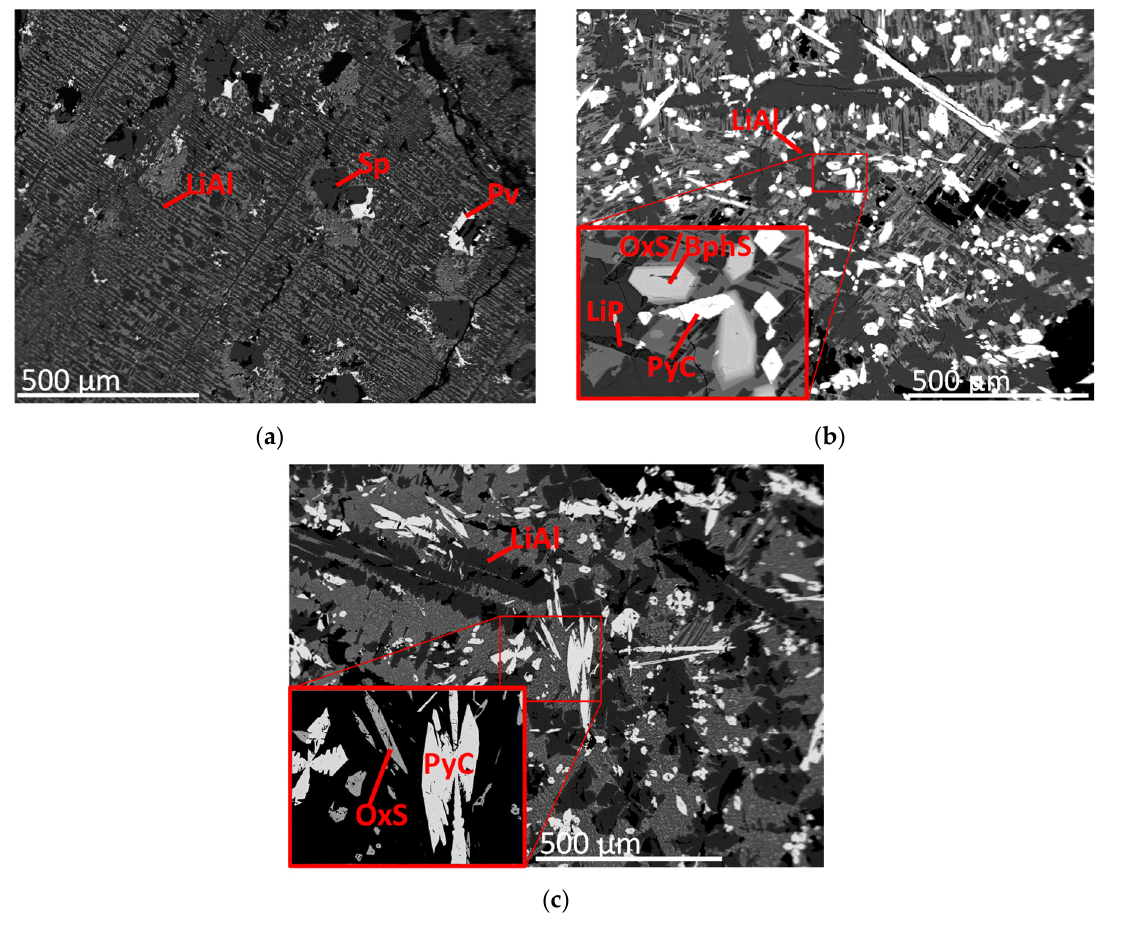
Figure 2. Overview of the morphologies and phase distributions of the three slag samples: ASSB-1 ( a ); ASSB-7 ( b ); and ASSB-10 ( c ), recorded using BSE(Z).